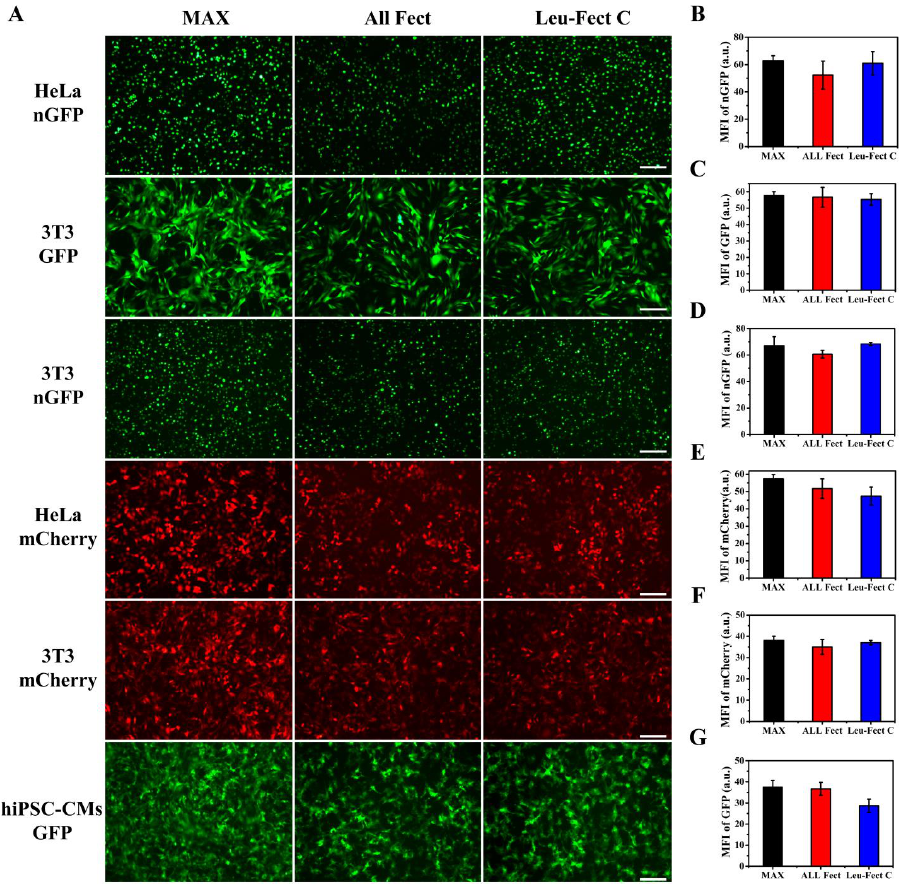
Figure 3. Assessment of lipopolymer modRNA delivery to mammalian cell types. ( A ) The transfec- tion expression of different modRNA at the optimal ratio was evaluated in HeLa, 3T3, and hiPSC-CMs. The scale bar represents 200 μm. ( B – G ) The mean fluorescence intensity (from Image J soft- ware version 1.8.0 analysis) for different cells after delivery of modRNA by the indicated vectors.